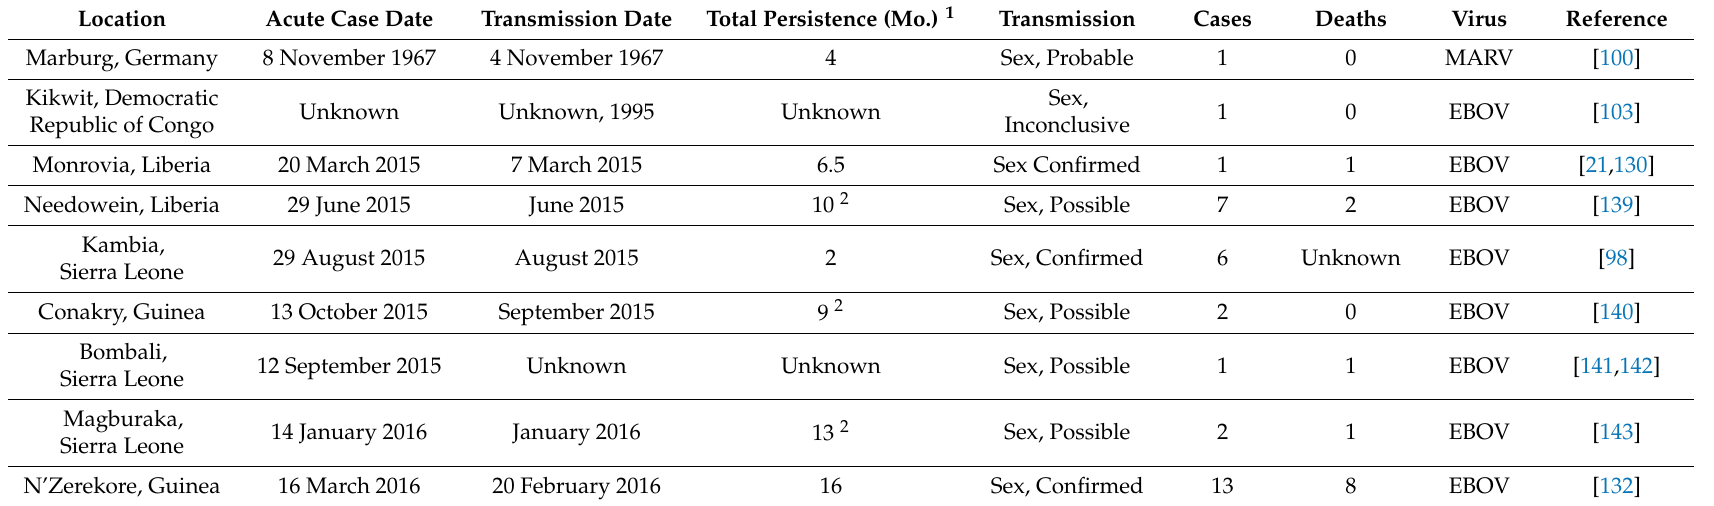
Table 3. Sexual transmission reports from